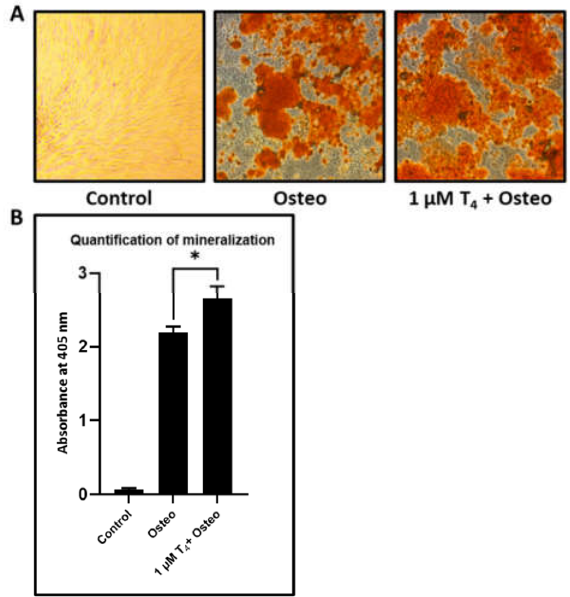
Figure 5. Osteogenic differentiation of DPSCs. ( A ) Differentiated osteoblasts from DPSCs and L-thyroxine treated DPSCs were stained for mineralization with alizarin red S. ( B ) Quantitation of alizarin red S for comparative estimation of mineralization in osteoblasts differentiated from DPSCs and L-thyroxine treated DPSCs ( n = 5). * p < 0.05. Osteo: osteogenic induction, T4: L-thyroxine. DPSCs: Dental pulp stem cells.